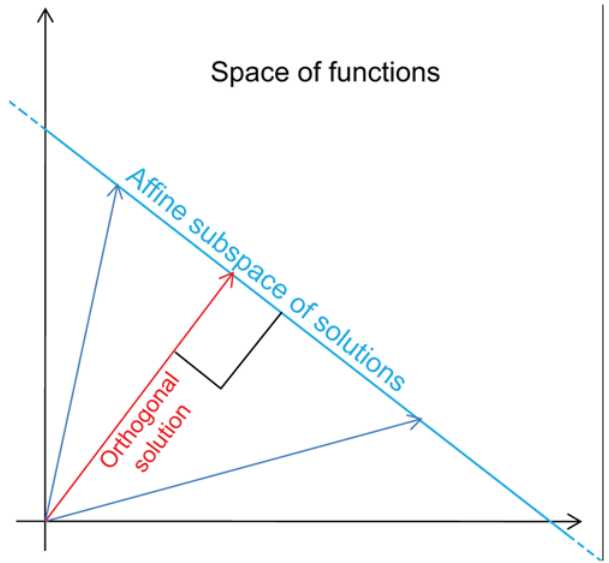
Figure 1. The set of all solutions to the polynomial interpola- tion problem is an affine subspace. A two-dimensional represen- tation of the space of functions F n F q (cid:4) (cid:5) . Within this space, a one- dimensional representation of the affine subspace of solutions of g ð Þ ~ ~ bb . Three particular solutions are depicted; one (red) is the W ~ XX orthogonal